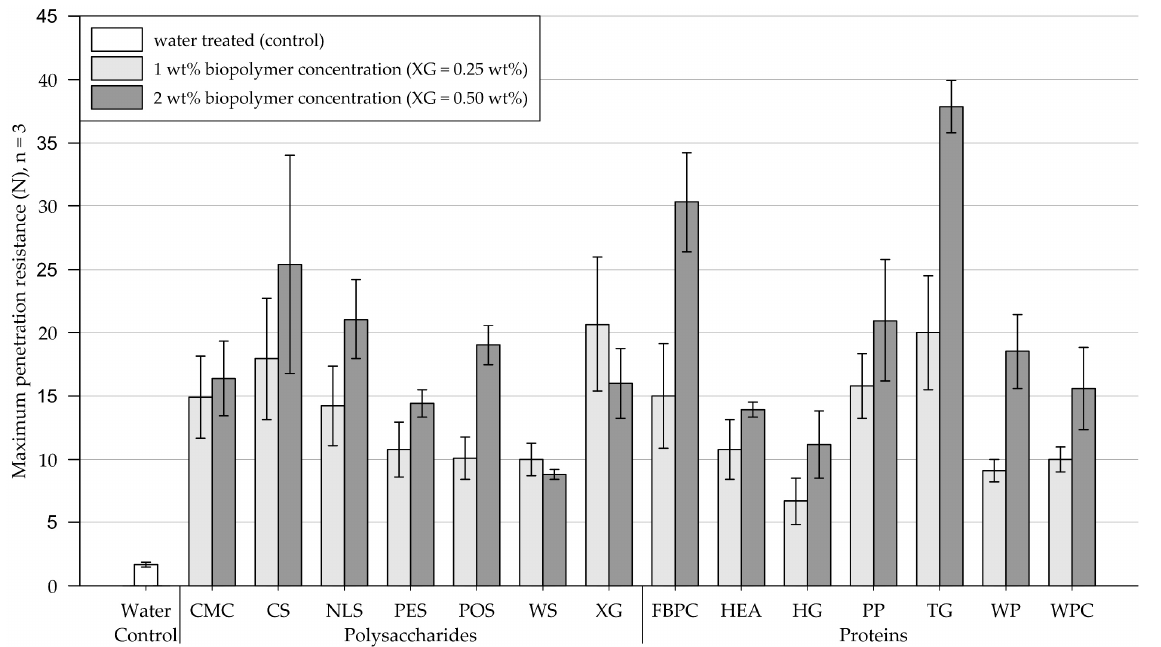
Figure 8. Mean maximum penetration resistance of crusts from fine-grained silica sand samples measured by penetrometer tests. Biopolymers are grouped into polysaccharides and proteins with water as control. Tests were performed in triplicates ( n = 3), with error bars indicating the standard deviation (SD). Note. The exact values of experimental results are appended in Table A3.